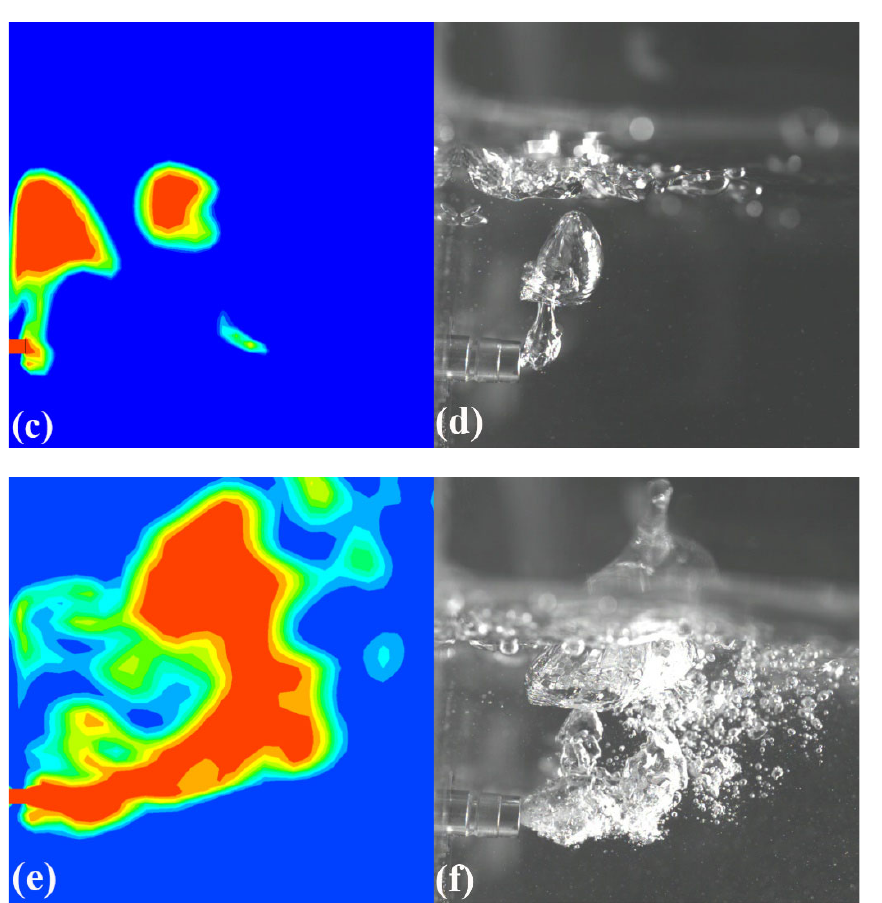
Figure 3. Comparison of simulation results ( a , c , e ) and experimental results ( b , d , f ) for 3 different flow regimes of airflow during side ‐ blown flow. regimes of airflow during side-blown